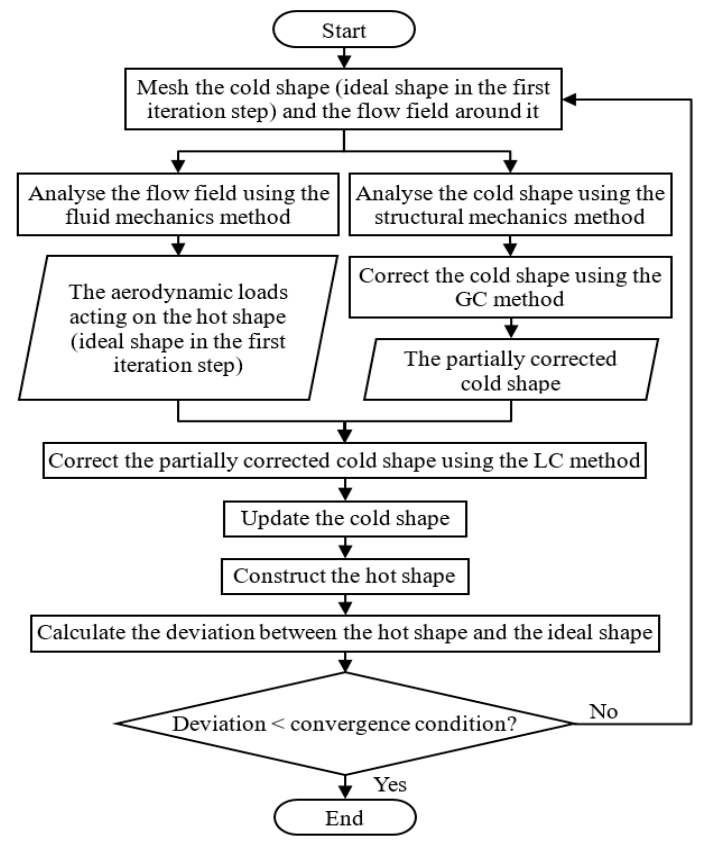
Figure 7. Pre-deformation design process based on the GLHC method.